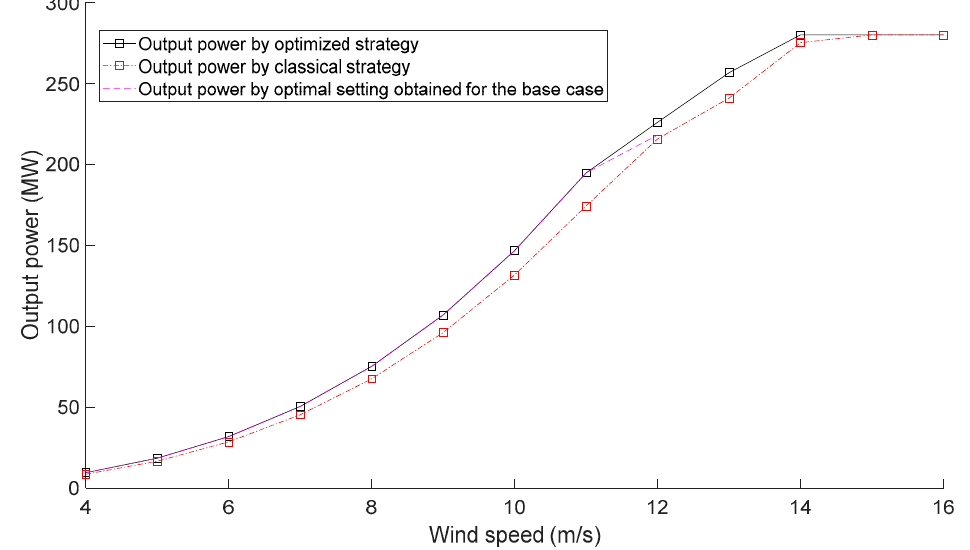
Figure 10. Sensitivity analysis as a function of incoming wind speed.